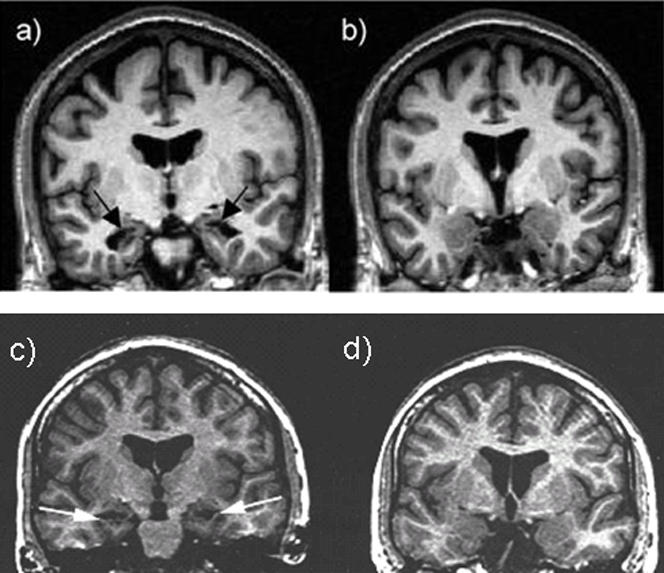
Anatomical images of amnesic patients.-T1 weighted coronal MRI sections of two of the patients35,36. Images reveal selective bilateral atrophy of hippocampus (a & d), and intact amygdala (b & c).